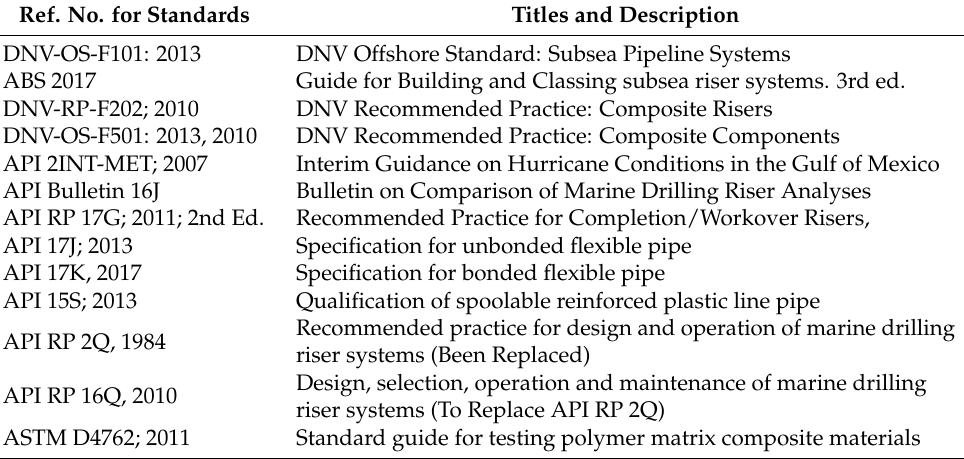
Table 3. Industry Standards, Codes and Guidelines on marine hoses, flexible pipes and composite marine